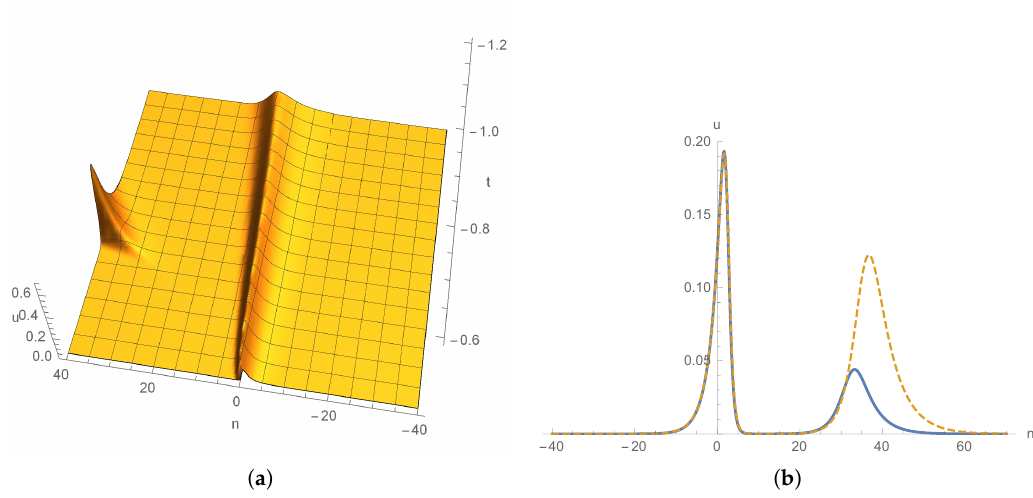
Figure 3. 2-soliton solutions for u n with c 1 = 0.05, c 2 = 0.06, d 1 = 1, d 2 = 1.2, α 1 = α 2 = 0.1 and β 1 = β 2 = − 0.1. ( a ) shape and motion; ( b ) waves in blue (solid line) and yellow (dotted line) stand for plot ( a ) at t = − 0.82 and t = − 0.83,